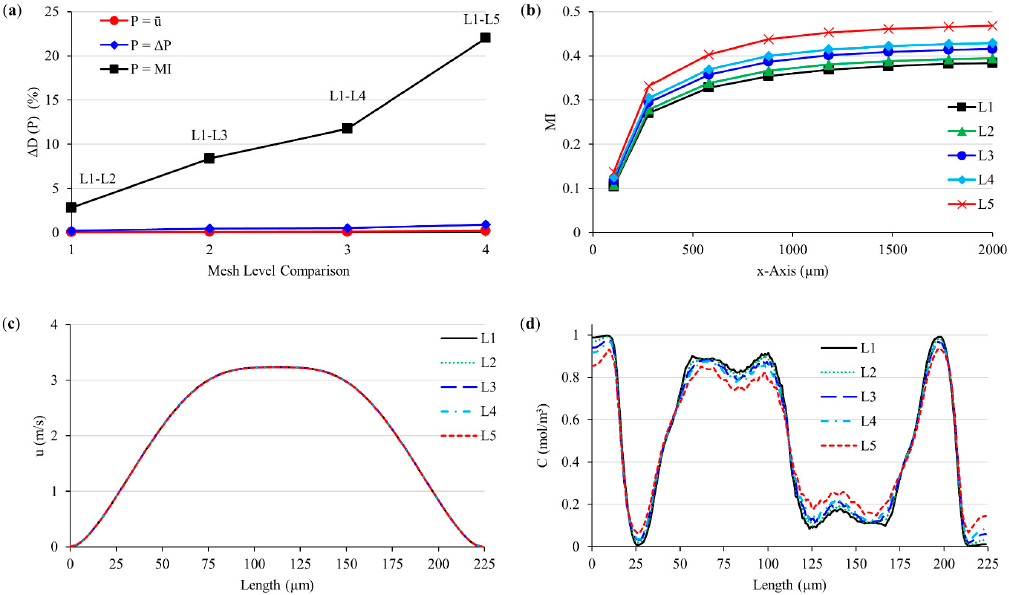
Figure 3. Grid study outcomes: ( a ) difference (%) between mesh levels for the parameters tested; ( b ) development of mixing on different y - z cross-sections along the mixing channel; ( c ) and ( d ) velocity and concentration distributions at the exit respectively (dashed line arrow II in Figure 1).